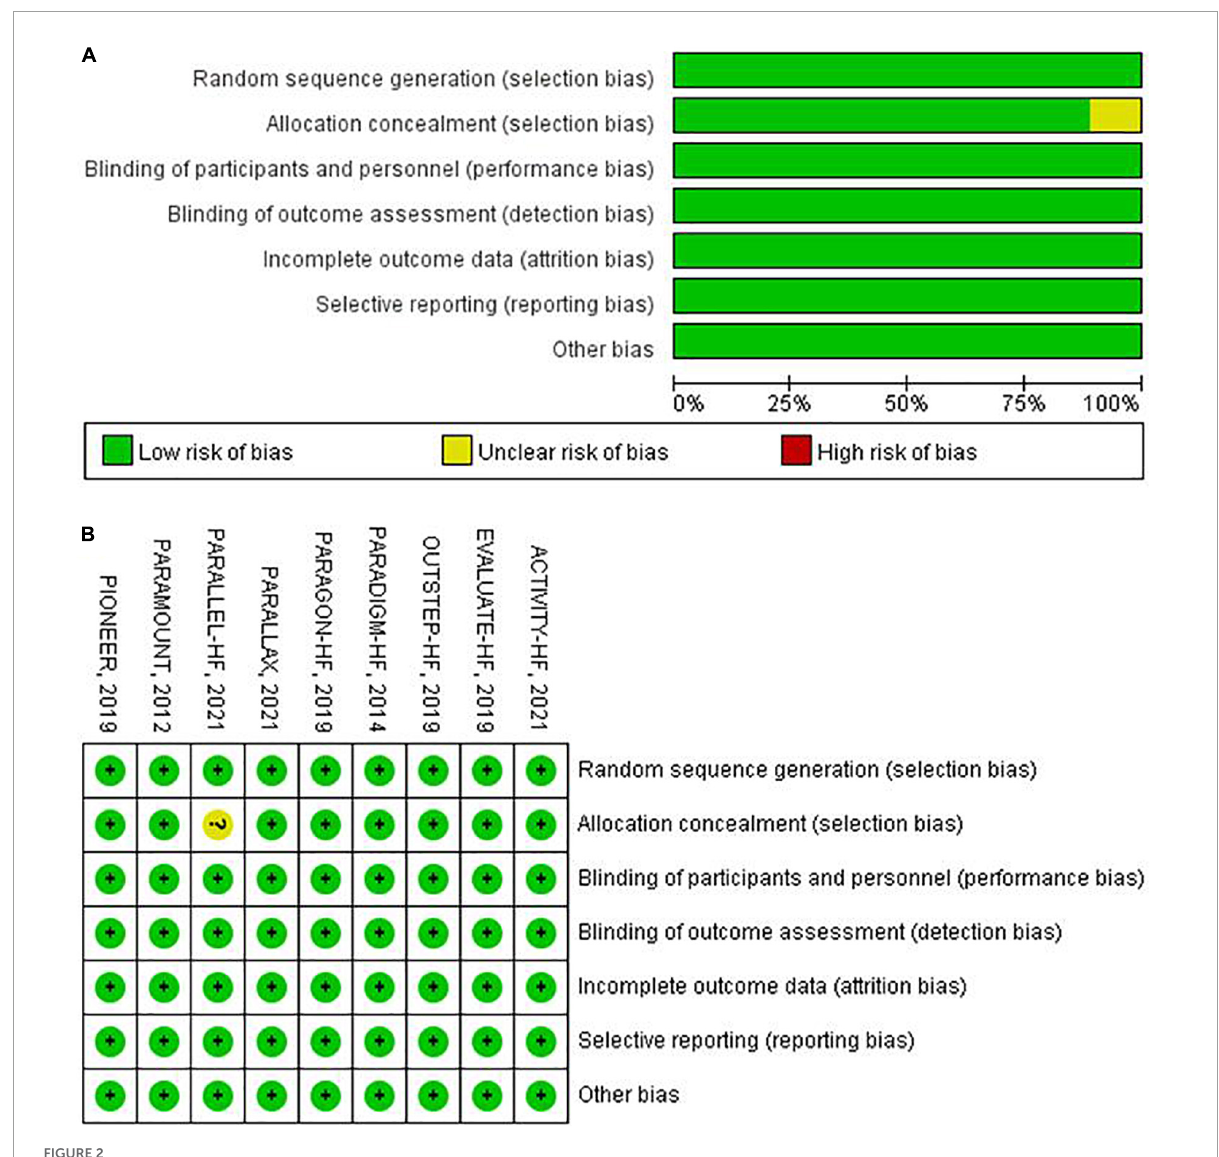
FIGURE2 Assessment of risk of bias. (A) Risk of bias graph, (B) risk of bias